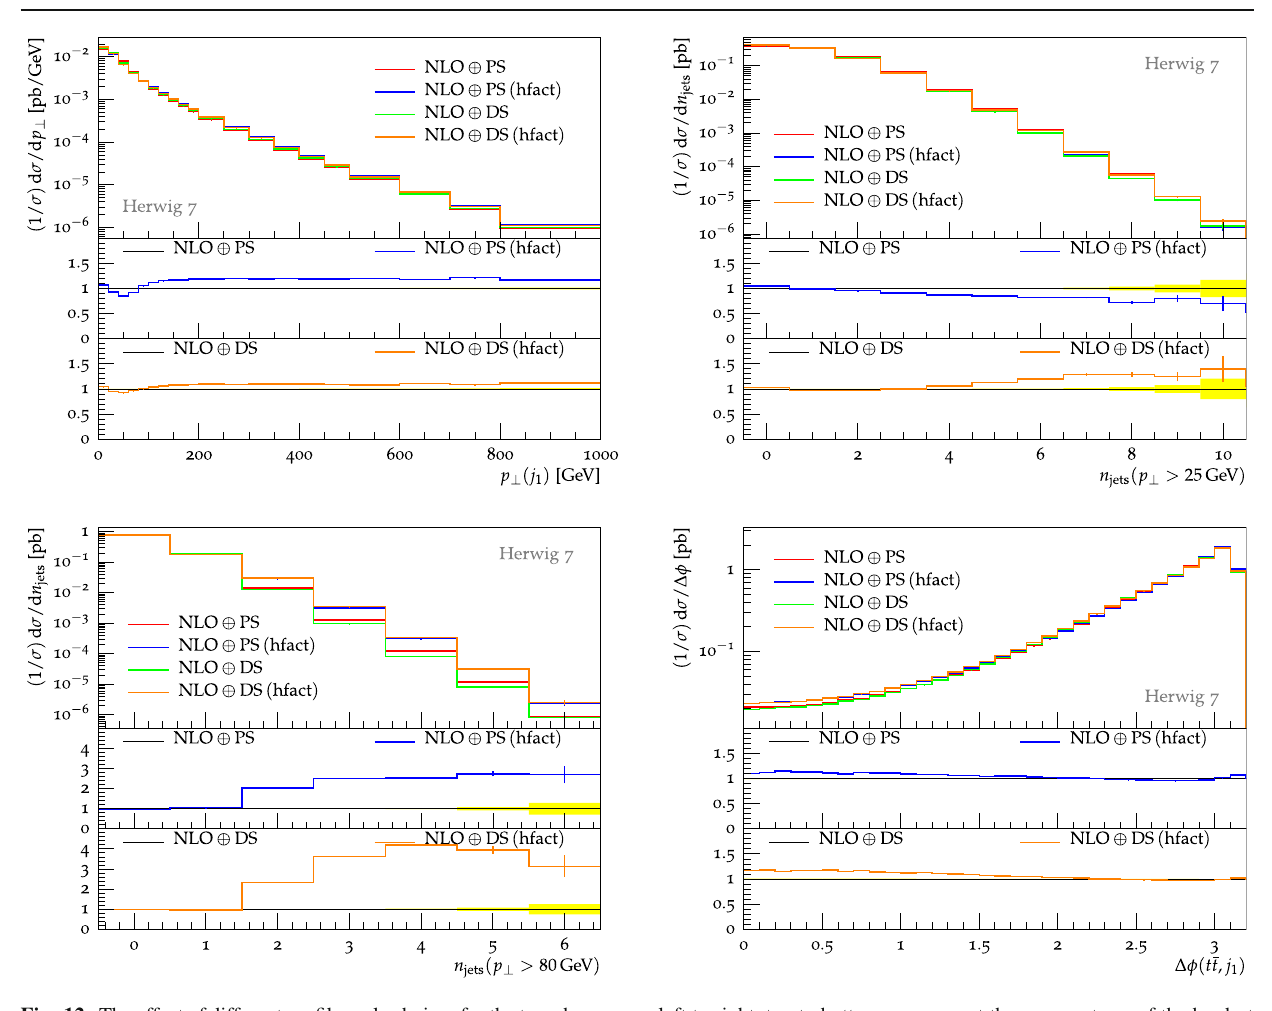
left to right, top to bottom, we present the p ⊥ spectrum of the hardest jet, the inclusive jet multiplicity at a threshold of 25 GeV and 80 GeV, respectively, as well as the azimuthal angle distance between the top pair and the hardest